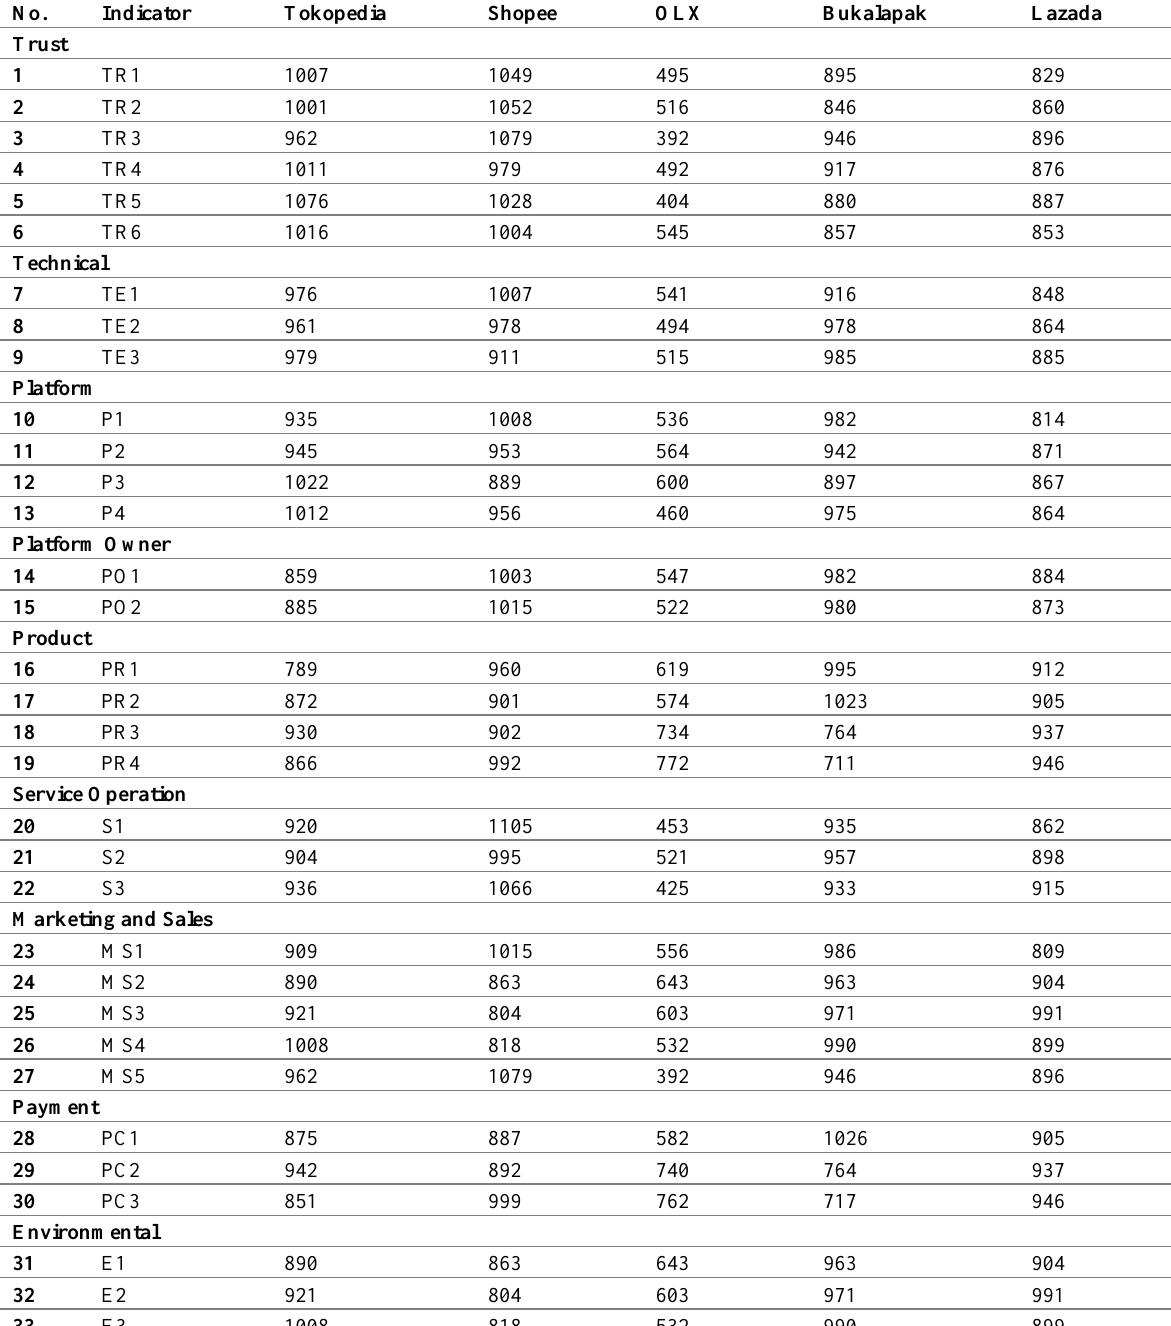
Table 4: Correspondence Analysis Input